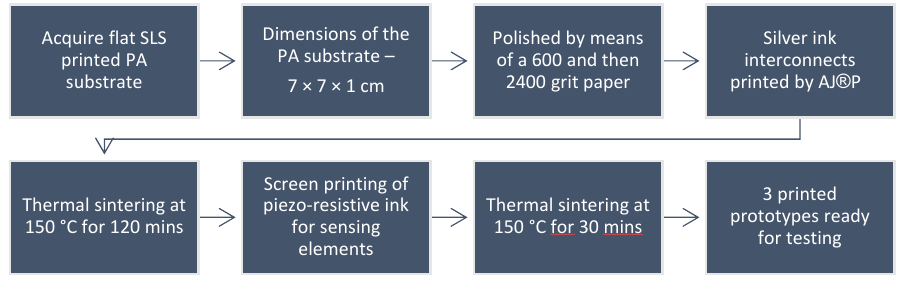
Figure 3. Process flow for the sensor’s prototype Figure 3.. Process flow for the sensor’s prototype manufacturing.